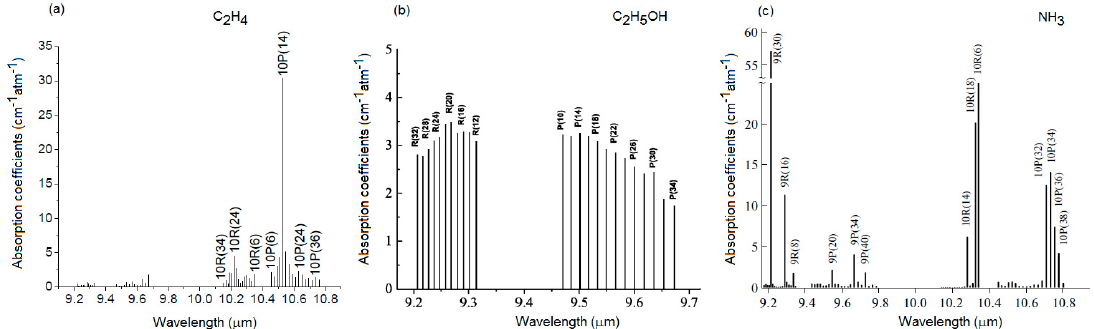
Figure 3. Absorption spectra of gases at CO 2 laser wavelengths. ( a ) Absorption spectra of ethylene, ( b ) Absorption spectra of ethanol, ( c ) Absorption spectra of ammonia.